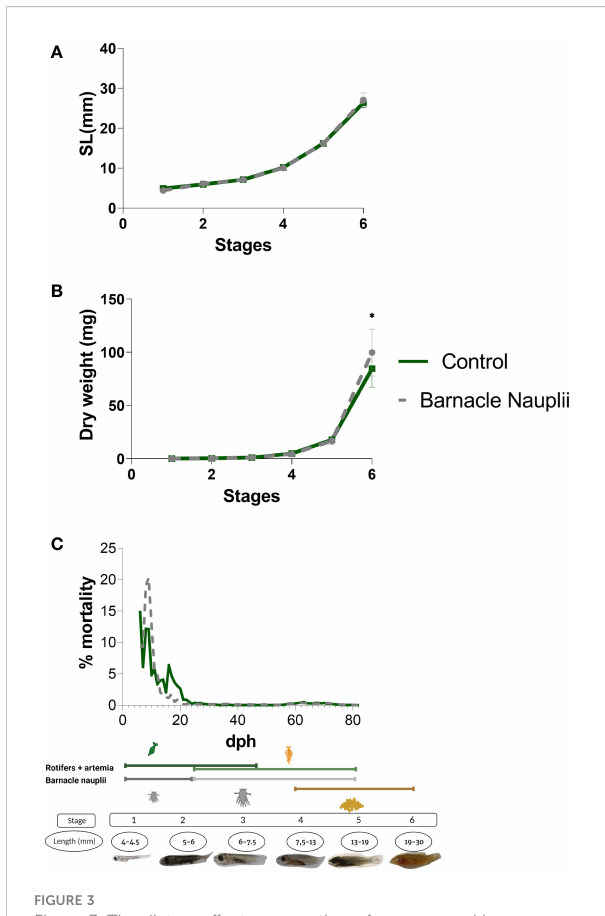
FIGURE 3 Figure 3. The dietary effect on growth performance and larvae mortality through ontogeny. (A) Larvae standard length (SL). (B) Larvae dry weight (DW) which was signi fi cantly higher in the barnacle nauplii diet in the last developmental stage (Mann-Whitney test, p value= 0.0287, indicated by *). (C) Mortality expressed in percentage. Stages and the feeding regime is included in the fi gure for eassier